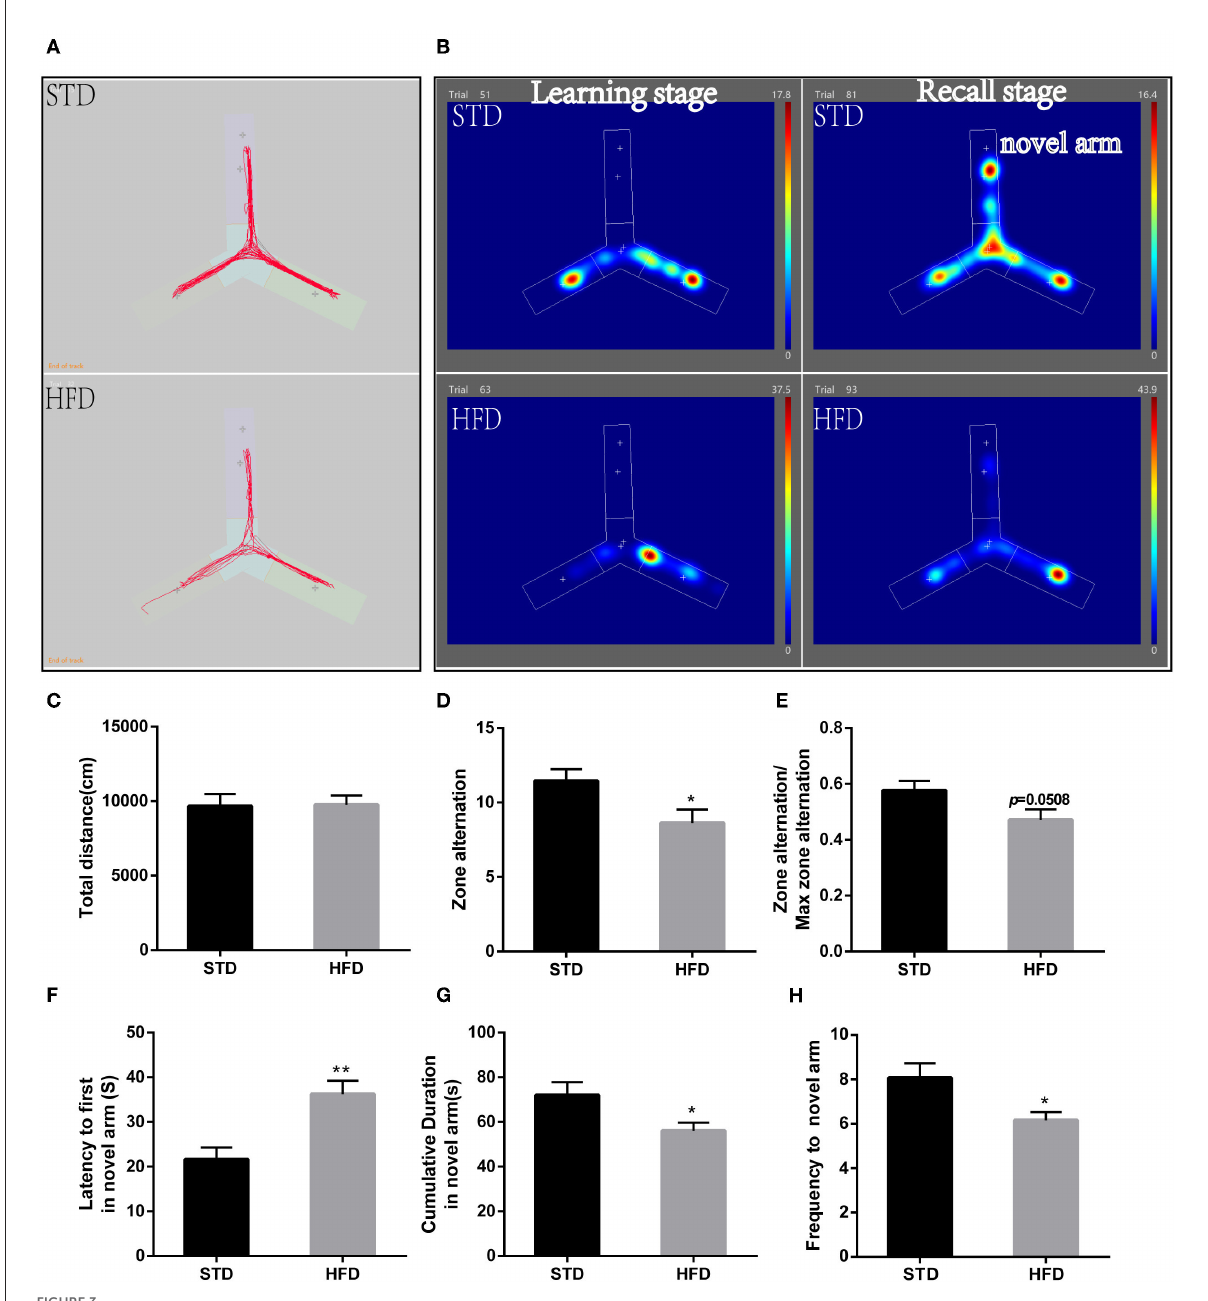
FIGURE3 The results of mice during Morris Y-maze test. (A) The trajectory map free exploration experiment spontaneous alternating reaction test. (B) The heatmap during the process of new environment and space identification experiments. (C) The total walking distance of mice during the test. (D) Times of zone alteration. (E) The percentage of alternation. (F) The escape latency of mice in the novel arm during the process of new environment and space identification experiments. (G) The escape latency of mice in the novel arm during the process of new environment and space identification experiments. (H) The frequency to novel arm during the process of new environment and space identification experiments.* P < 0.05; ** P < 0.01. Both in the spontaneous alternating reaction test and the process of new environment and space identification experiments, three replicate experiments were performed for each mouse, and mean values were calculated for final analysis. n = 12,